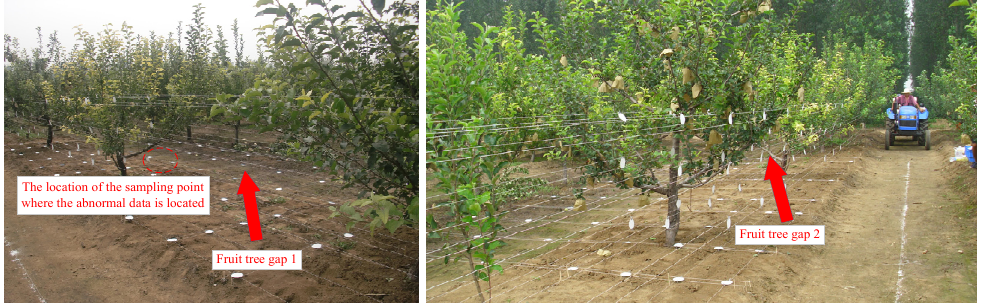
Figure 16. Sampling point location of abnormal data.